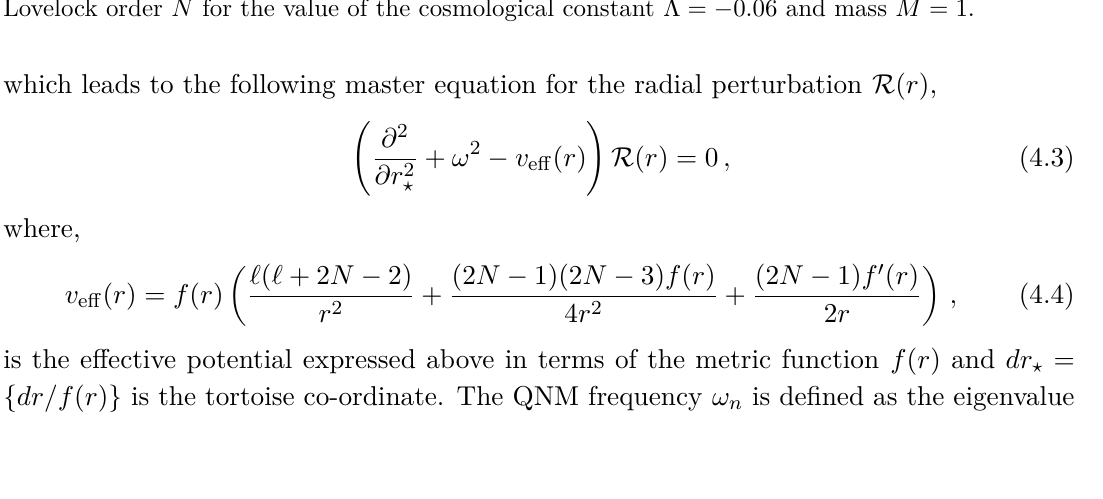
Table 4 . We have plotted the analytical values of the ratio − ( Im ω/κ − ) for different value of the Lovelock order N for the value of the cosmological constant Λ = − 0 . 06 and mass M = 1